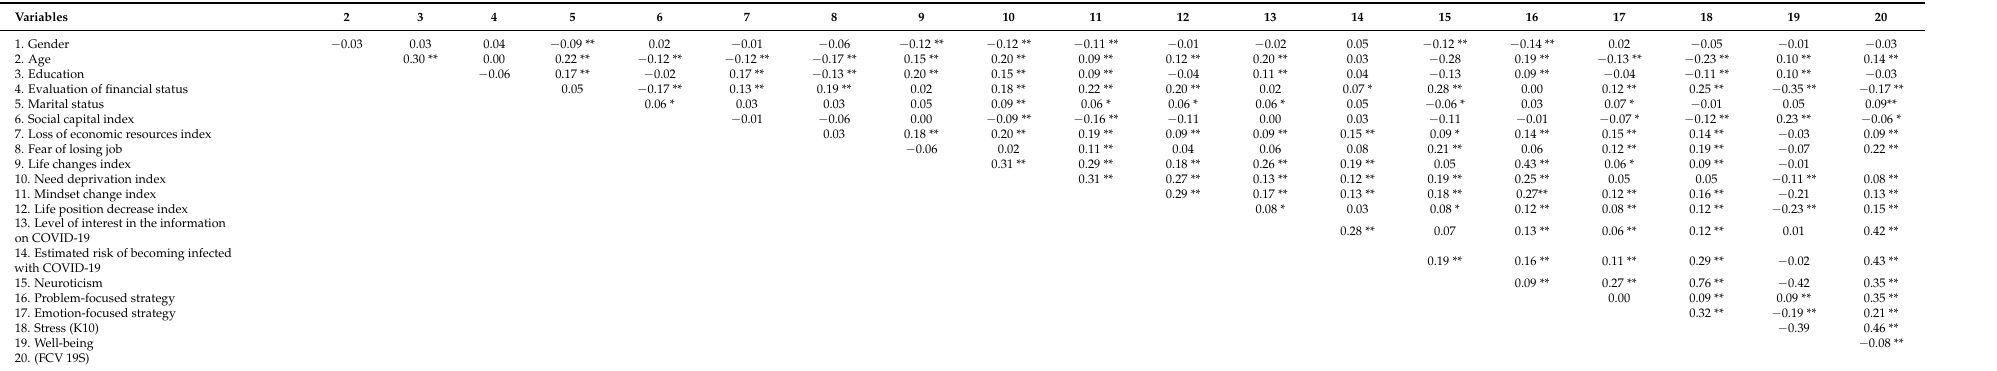
Table 3. Correlation